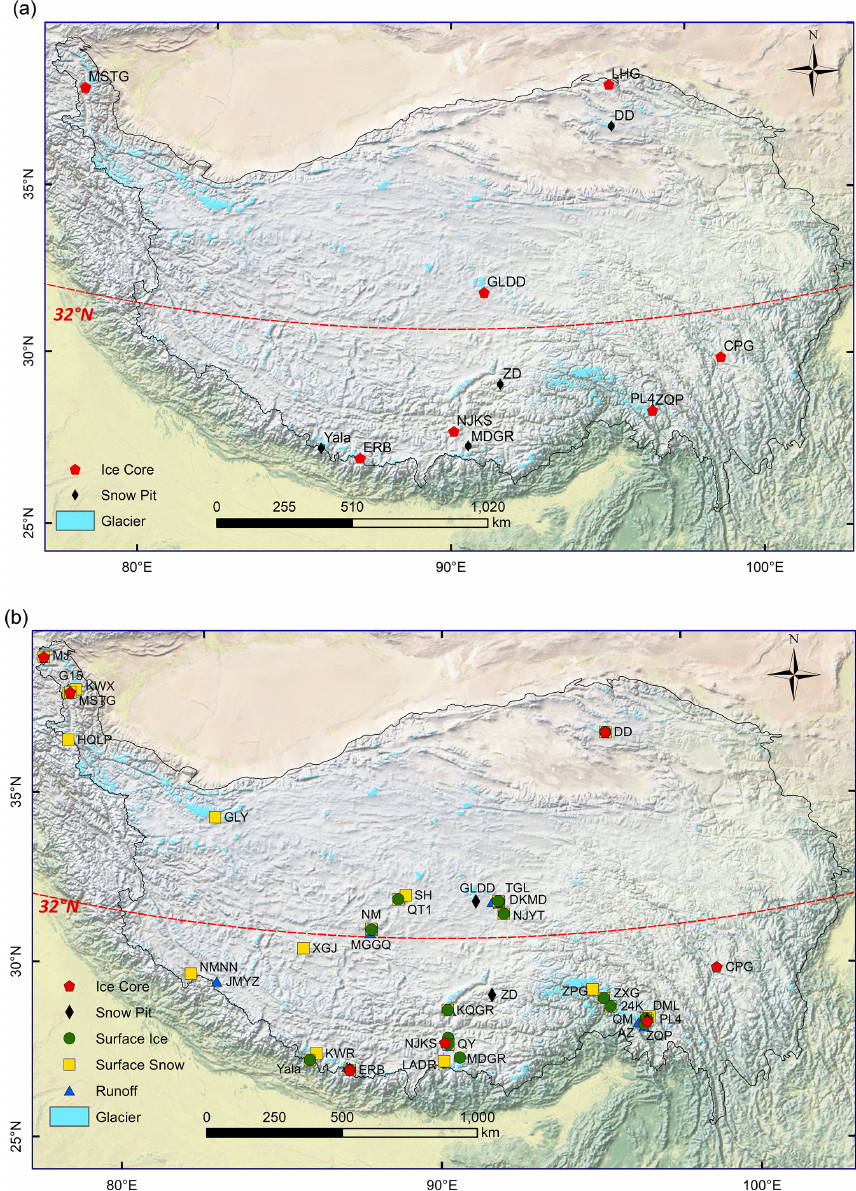
Figure 1. Location of sampled glaciers for microbial abundance (a) as well as DOC and TN (b) on the Tibetan Plateau. The abbreviations of glacier names are labeled in the map and the full names are available in the